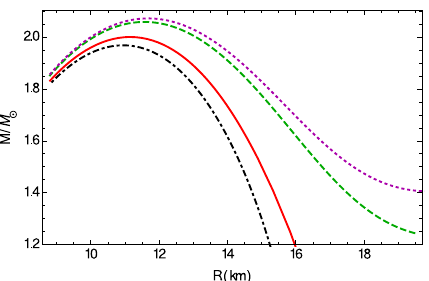
Fig. 24 Variations of the mass M / M (cid:2) of the three-form field Bose– Einstein condensate stars as functions of the radius of the star R , for three different values of the constant field potential ¯ λ : ¯ λ = 0 (dashed curve), ¯ λ = 0 . 0013 (dotted curve), and ¯ λ = − 0 . 01 (dot-dashed curve). The solid curve represents the mass–radius relation for Bose–Einstein condensate stars in standard general